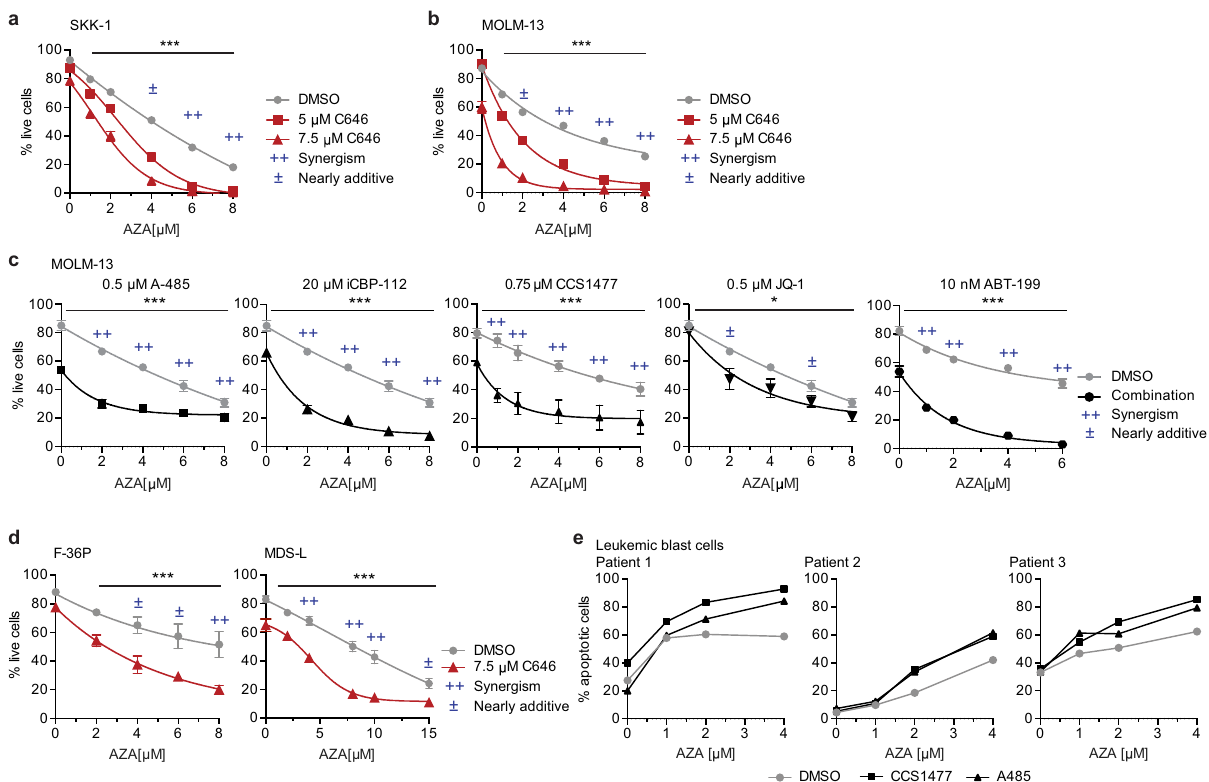
Fig. 2 Inhibition of CBP/p300 increases sensitivity towards AZA in AML cells. a , b Percentage of live SKK-1 ( a ) or MOLM-13 cells ( b ) determined by DAPI/MitoTracker staining after 4 days of treatment with indicated concentrations of AZA in combination with C646 or 0.075% DMSO as vehicle control. c Percentage of live MOLM-13 cells after 4 days of treatment with different concentrations of AZA in combination with indicated concentrations of the CBP/p300 inhibitors A-485, iCBP-112 and CCS1477, the BET bromodomain inhibitor JQ-1, the BCL-2 inhibitor ABT-199 or 0.03% DMSO as vehicle control. d Percentage of live F-36P or MDS-L cells after 4 days of treatment with indicated concentrations of AZA in combination with C646 or DMSO (0.075%) as vehicle control. e Percentage of apoptotic leukemic blast cells from three AML patients determined by Annexin V staining after 3 days of treatment with different concentrations of AZA and 2 days with 500 nM CCS1477 or 8 µ M A-485, or 0.08% DMSO as vehicle control. a – d Combination index (CI) was calculated according to the Chou – Talalay method 43 . ++ synergism (CI: 0.3 – 0.85), ± additive effect (CI: 0.9 – 1.1). Data represent the mean ± SEM of four independent experiments. Statistical analysis was performed using two-way ANOVA. * p -value < 0.05; *** p -value < 0.0001. Source data are provided as a Source Data fi